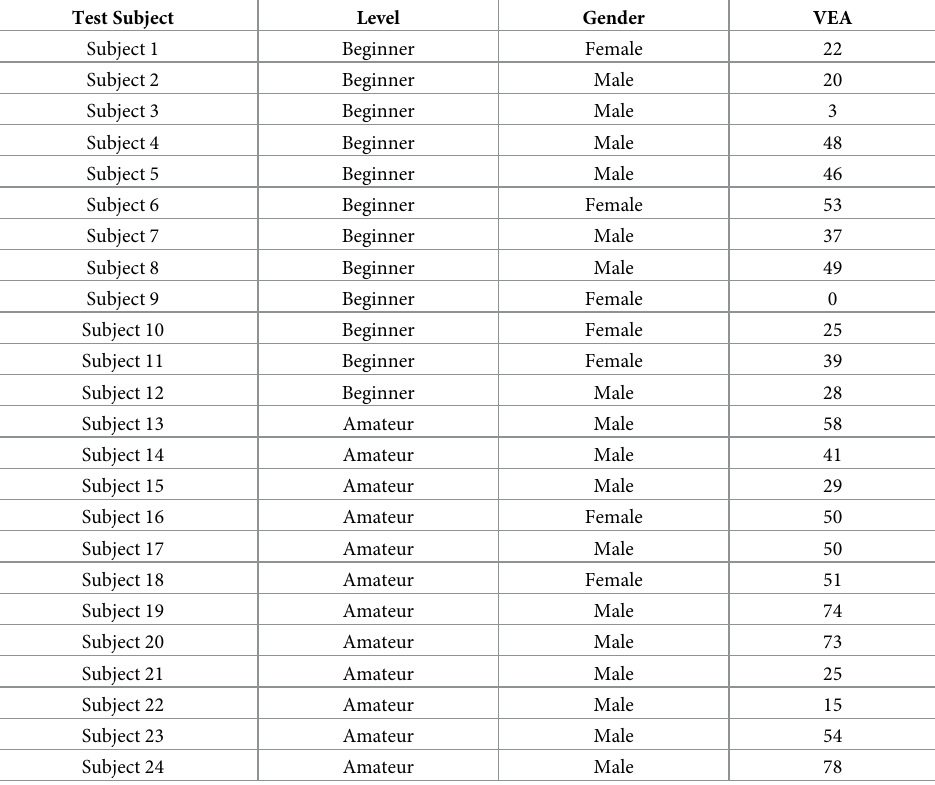
Table 1. VEA scores by test subject during the “Test” scene, paired by their level of